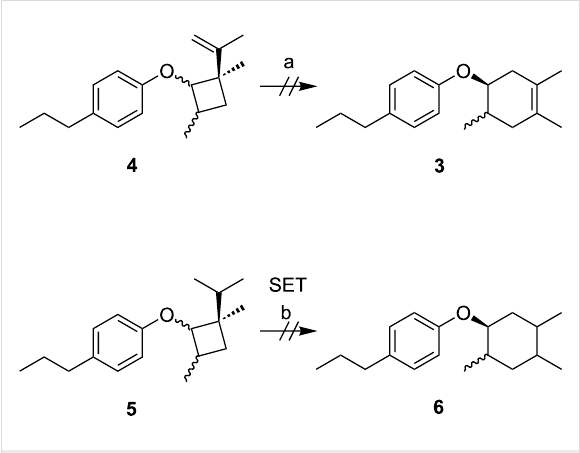
Scheme 6: Unsuccessful rearrangement of cyclobutanes. Conditions: 1.0 M LiClO 4 /CH 3 NO 2 , carbon felt electrodes, a) no electricity, b)1.2 V vs Ag/AgCl, 0.1